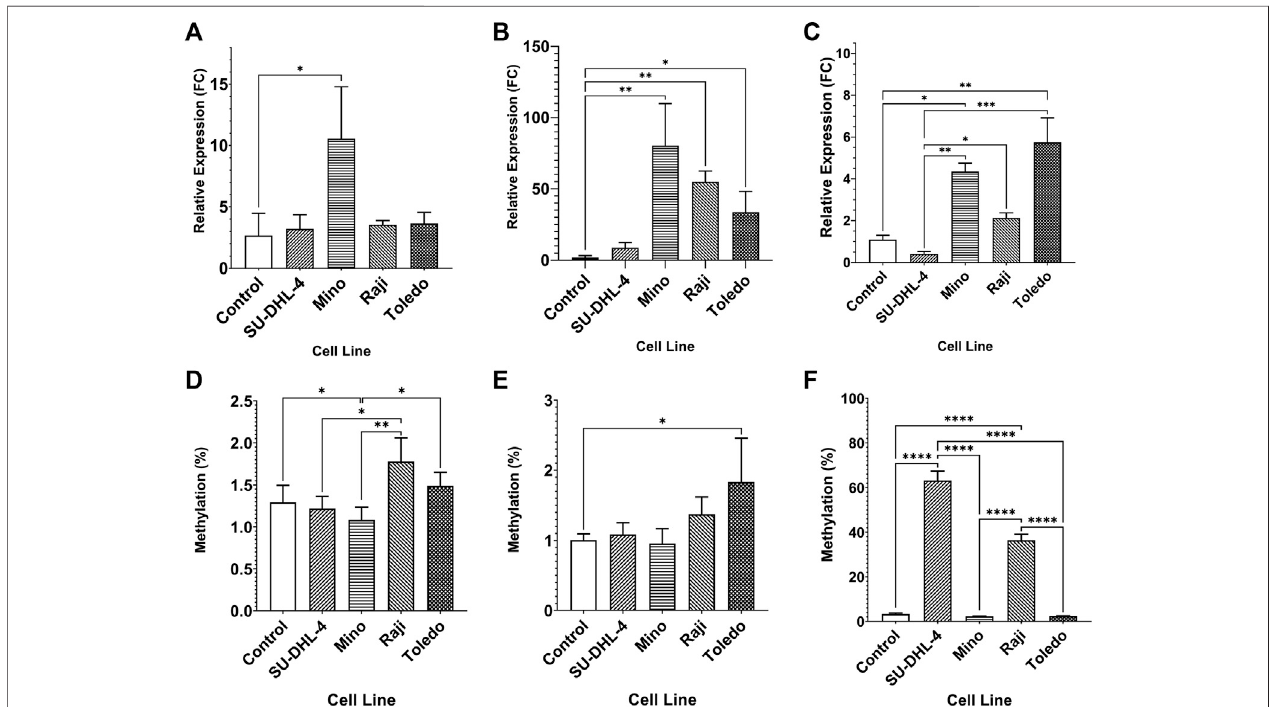
FIGURE2 | Expression miRNA 92a-3p,miRNA92a-3p,and TET2 mRNA, and promoter DNA methylation ofCpGs in tworegionsof thepromoter CGI ofthe miR- 17 ∼ 92 cluster and one region in the promoter CGI of the TET2 gene in NHL cell lines and in healthy control PBMCs. The expression of miR-92a-3p (A) , miR-92a-5p (B) and TET2 mRNA (C) was assayed by RT-qPCR in commercially available NHL cell lines SU-DHL-4, Mino, Raji, and Toledo, and in healthy control PBMCs. Bisul fi te pyrosequencing was performed on two regions in the promoter CGIs of the miR-17 – 92 cluster and in one region of the TET2 gene in the same cells and controls. Meanmethylationlevelsof4CpGsinthetworegions,532 bp (D) andbp (E) upstreamofthe MIR17HG TSSwereassayed,andmeanmethylationlevelsof6CpGsinthe fi rst exon of TET2 were also assayed (F) . Bars denote mean and error bars denote SEM. Statistical signi fi cance calculated by KW test of signi fi cance and a post-hoc Dunn test for comparison of cell lines to controls, with signi fi cance denoted as: **** p < 0.0001, *** p < 0.001, ** p < 0.01, * p < 0.05.